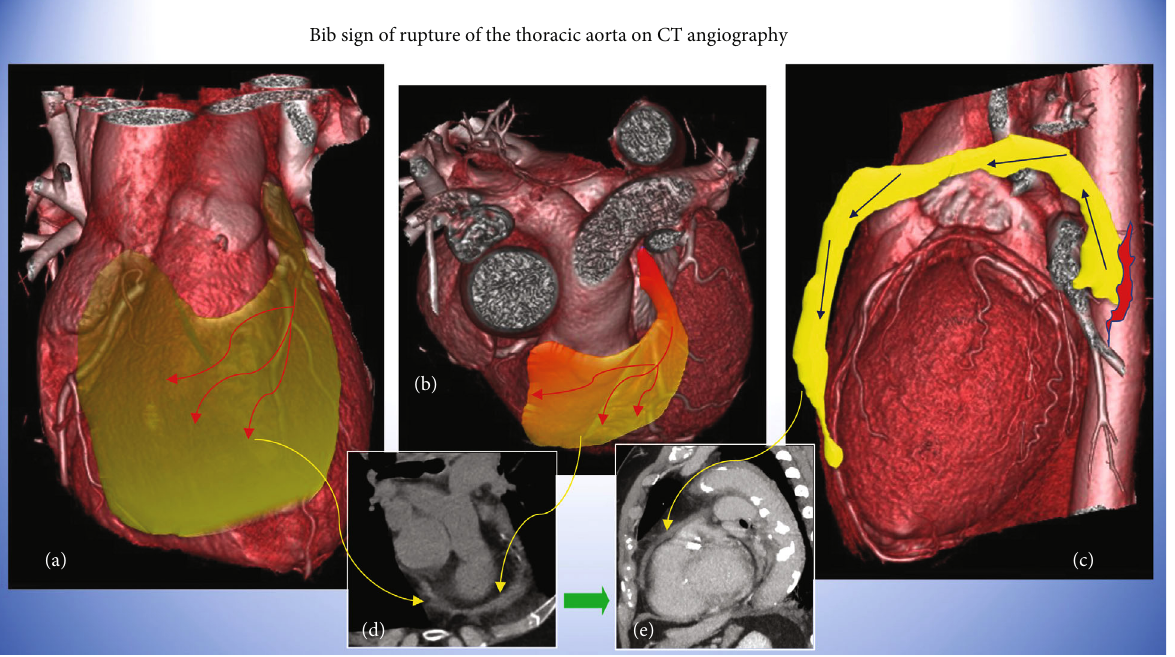
Figure 4: 3D volume-rendering of the heart evaluated through various angles, demonstrating how the bib-like mediastinal hematoma is arranged and the path that it travels from the rupture site of the proximal descending thoracic aorta, up to the anterior surface of the heart (a – c). Corresponding CT images (d,